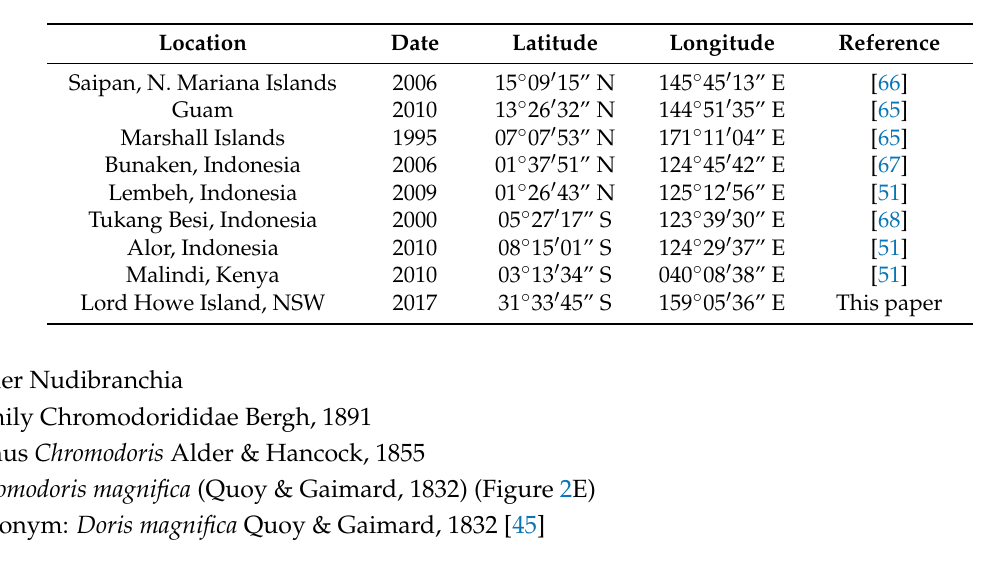
Table 5. Selected global distribution records of Thuridilla flavomaculata.